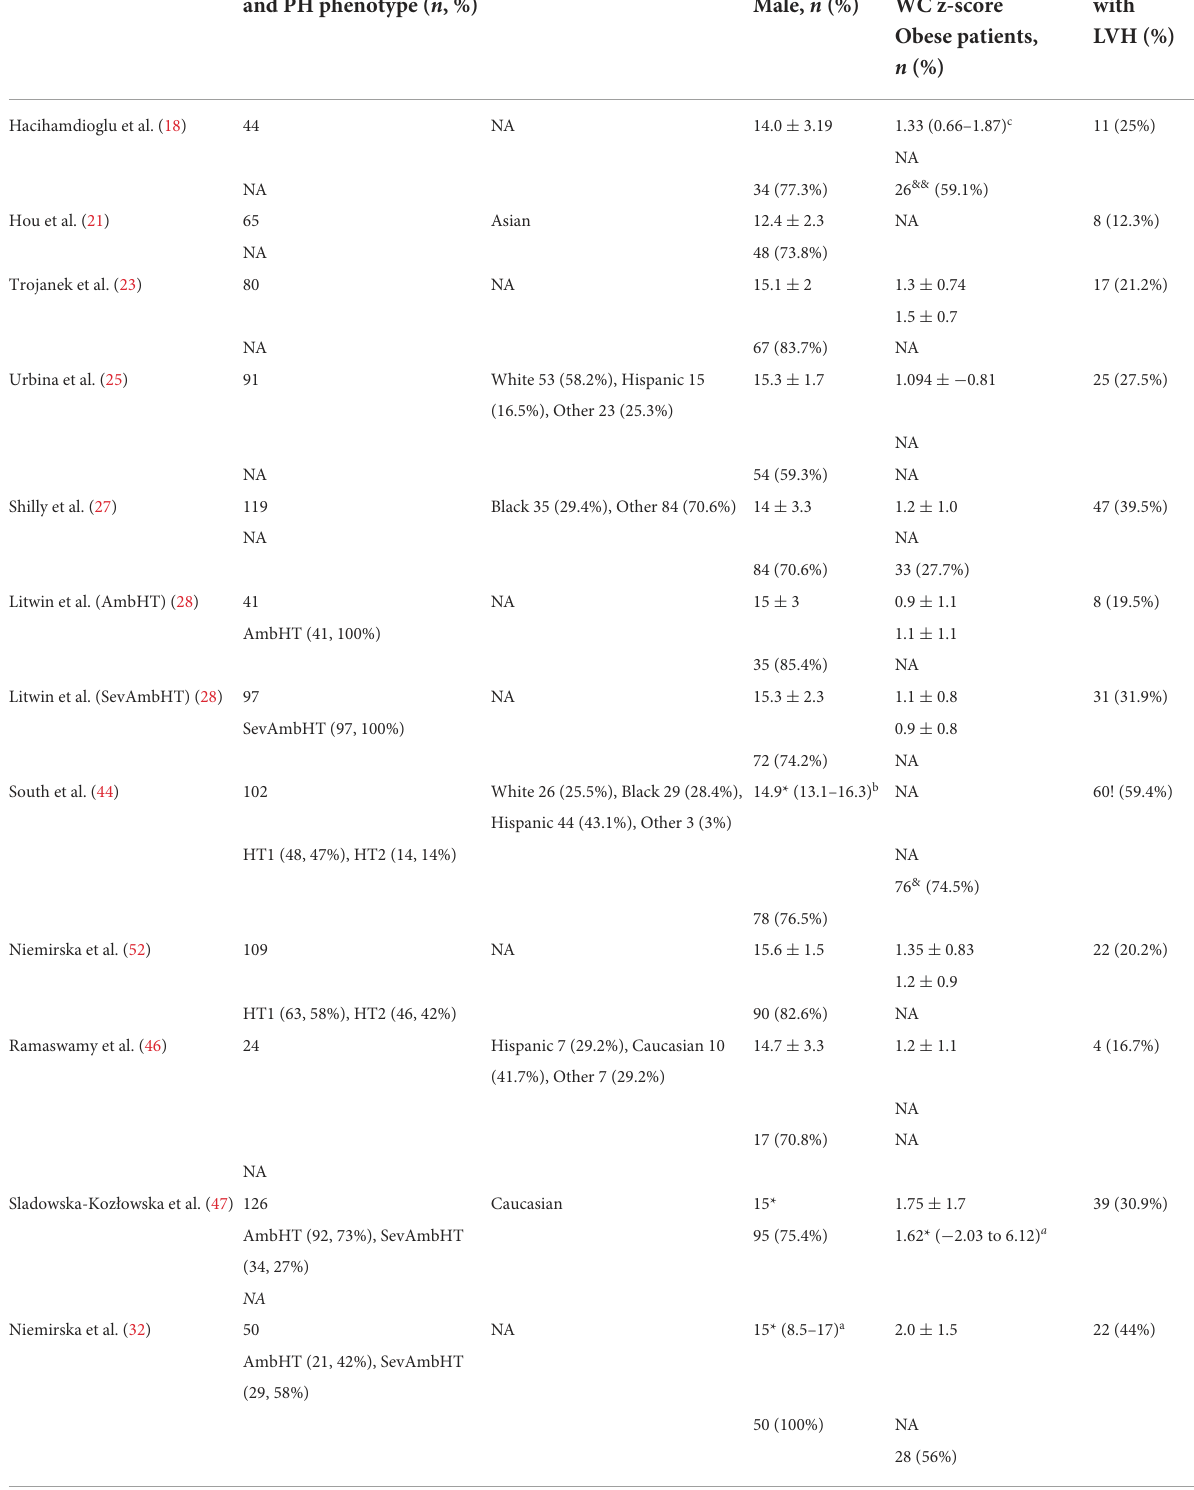
TABLE 1 Characteristics of samples included in the main analysis (Subgroup